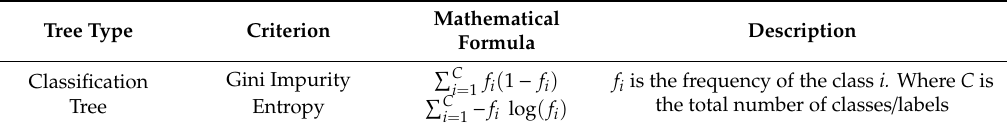
Table 1. Node Impurity Splitting